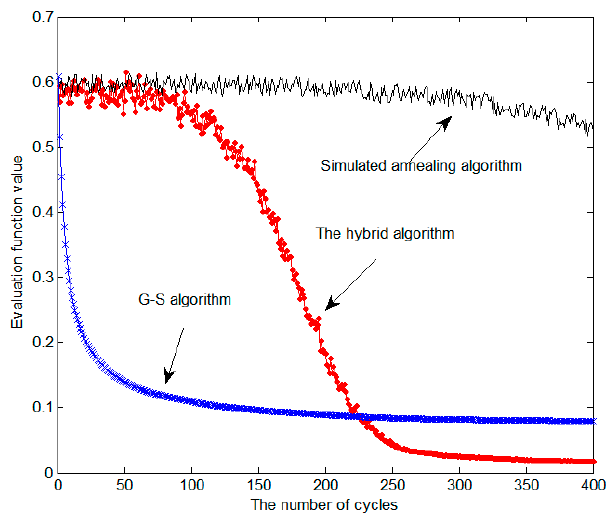
Figure 6. The comparison of convergence properties of three algorithms.